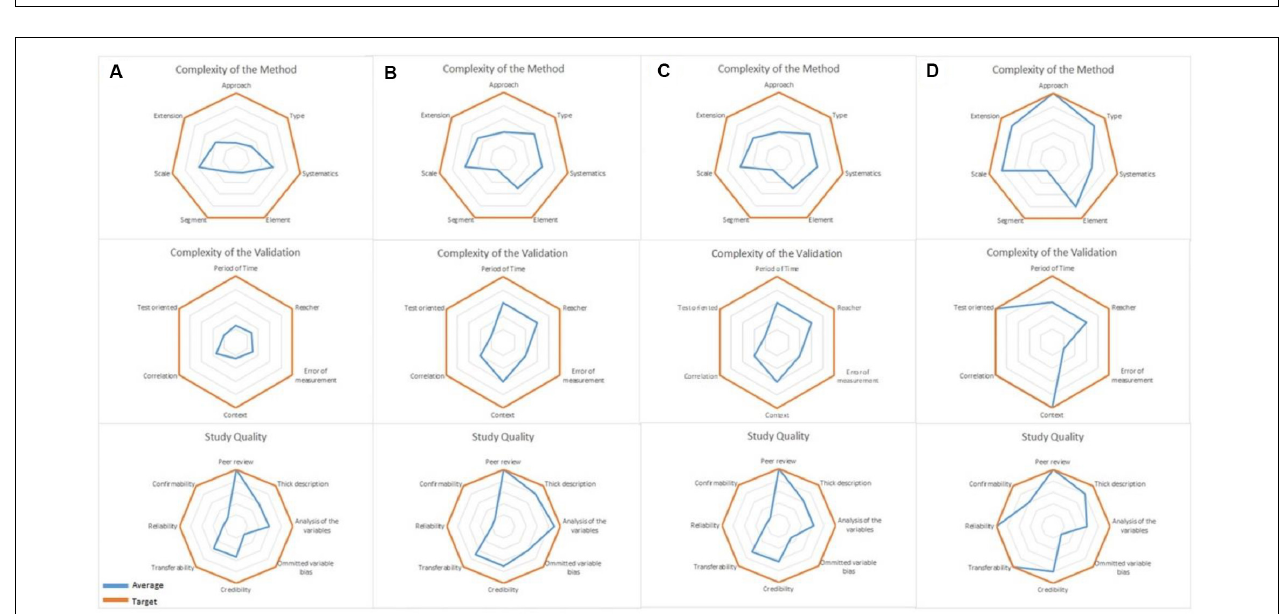
FIGURE 5 | The average of complexity of both the method and the validation, and the study quality of the primary studies classified in groups: (A) L-I, (B) L-II-b, (C) L-II-a, and (D) L-III.